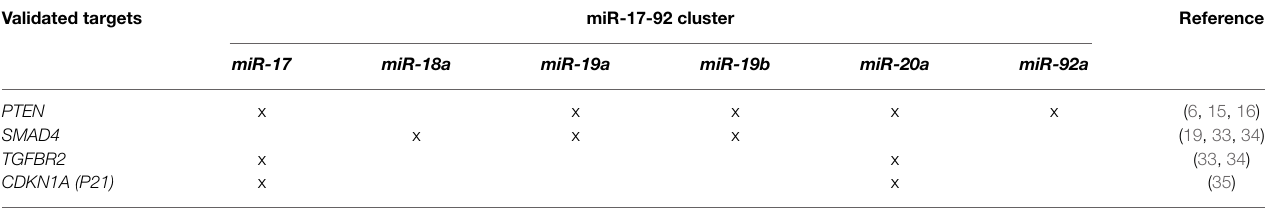
TABLE 1 | Validated miR-17-92 targets